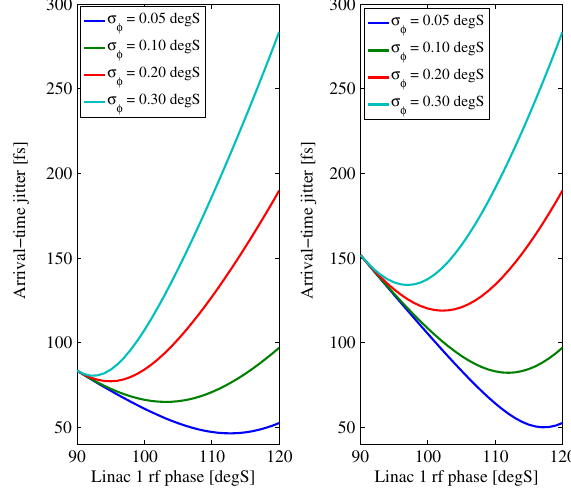
FIG. 2. dV=V ¼ 0 : 02% , dB=B ¼ 0 : 01% , R 56 ¼ (cid:3) 41 mm . Injector exit rms time jitter 80 fs (left) and 150 fs (right).